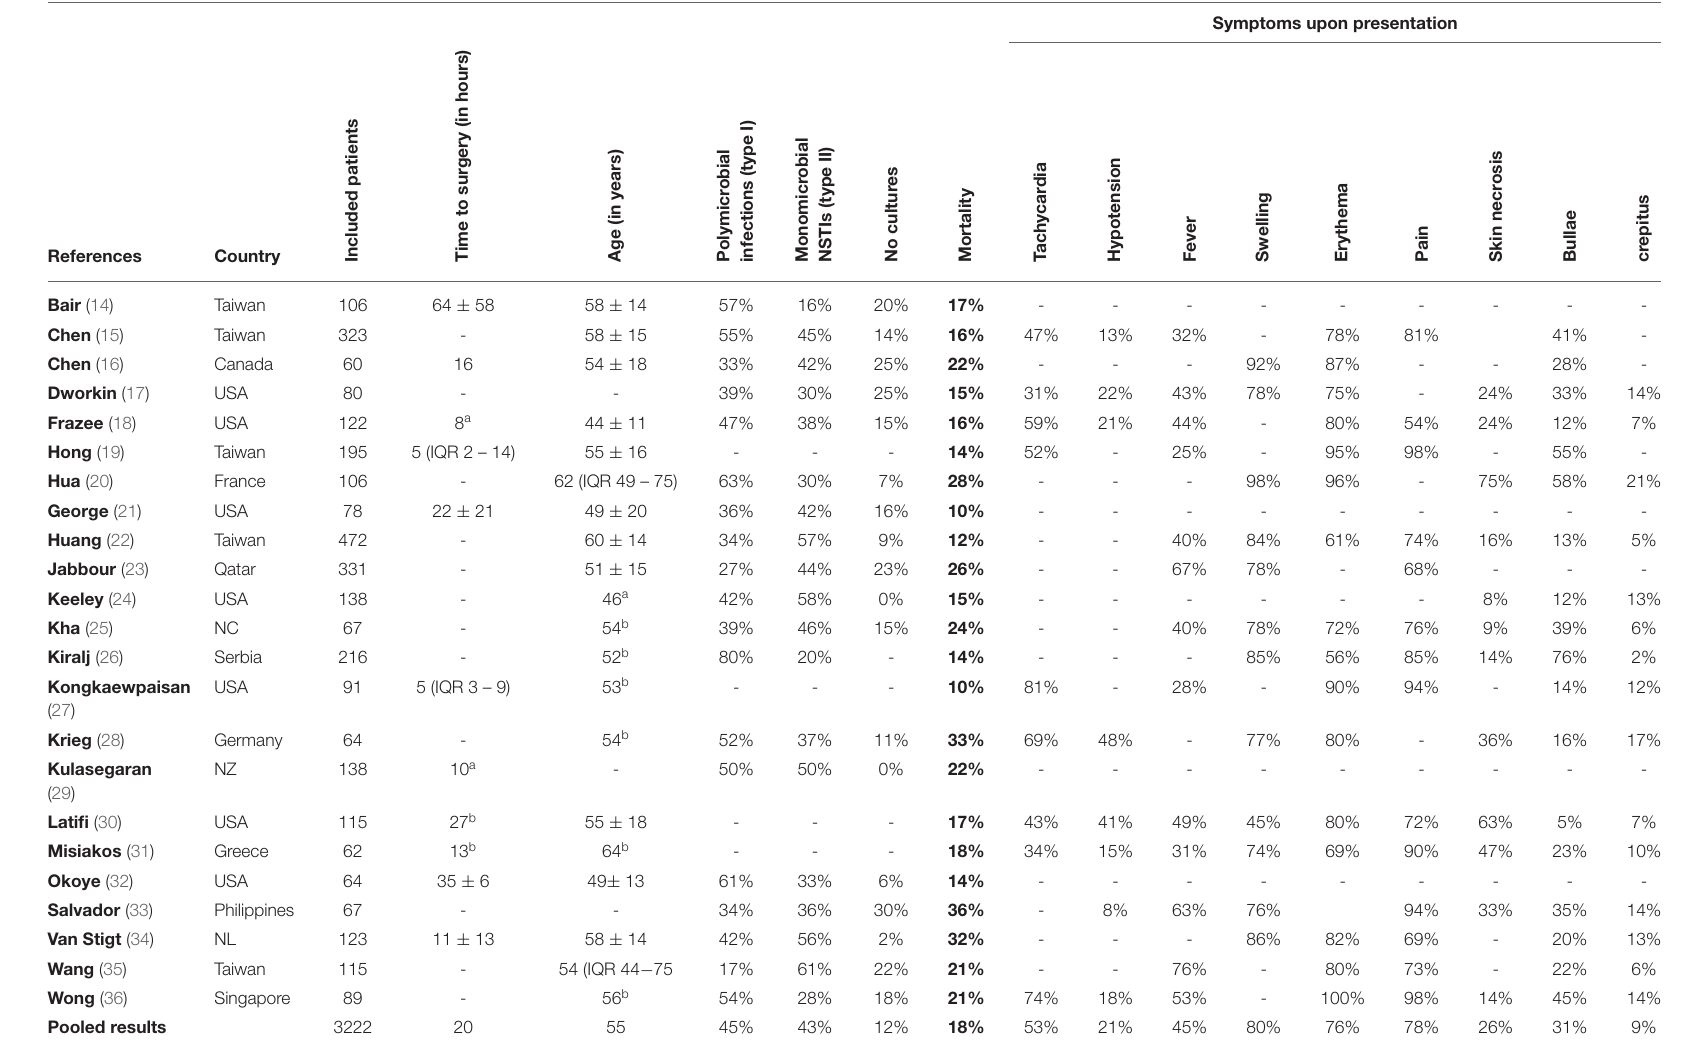
TABLE 1 | Overview of large necrotizing soft tissue infection studies published since 2000 reporting on microbiology, time to surgery and/or presenting